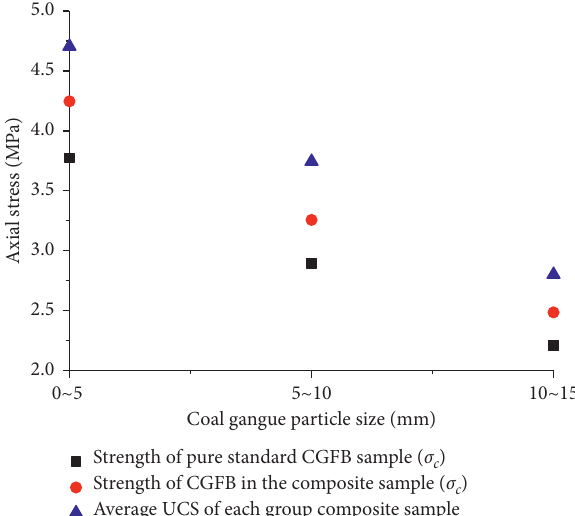
Figure 11: Comparisons of σ composite